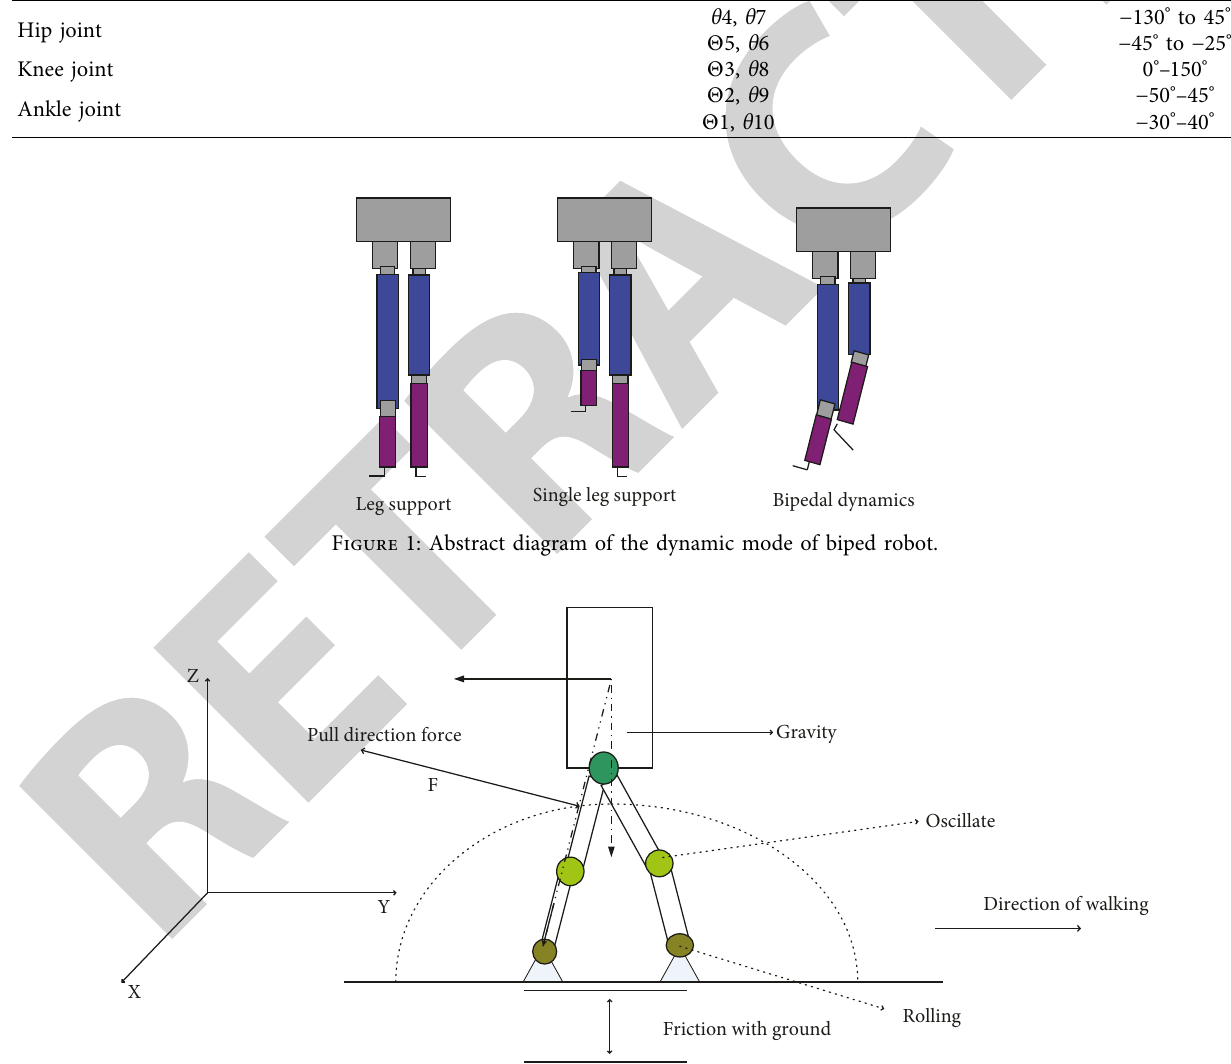
Table 2: Motion boundary table of each part of the robot.